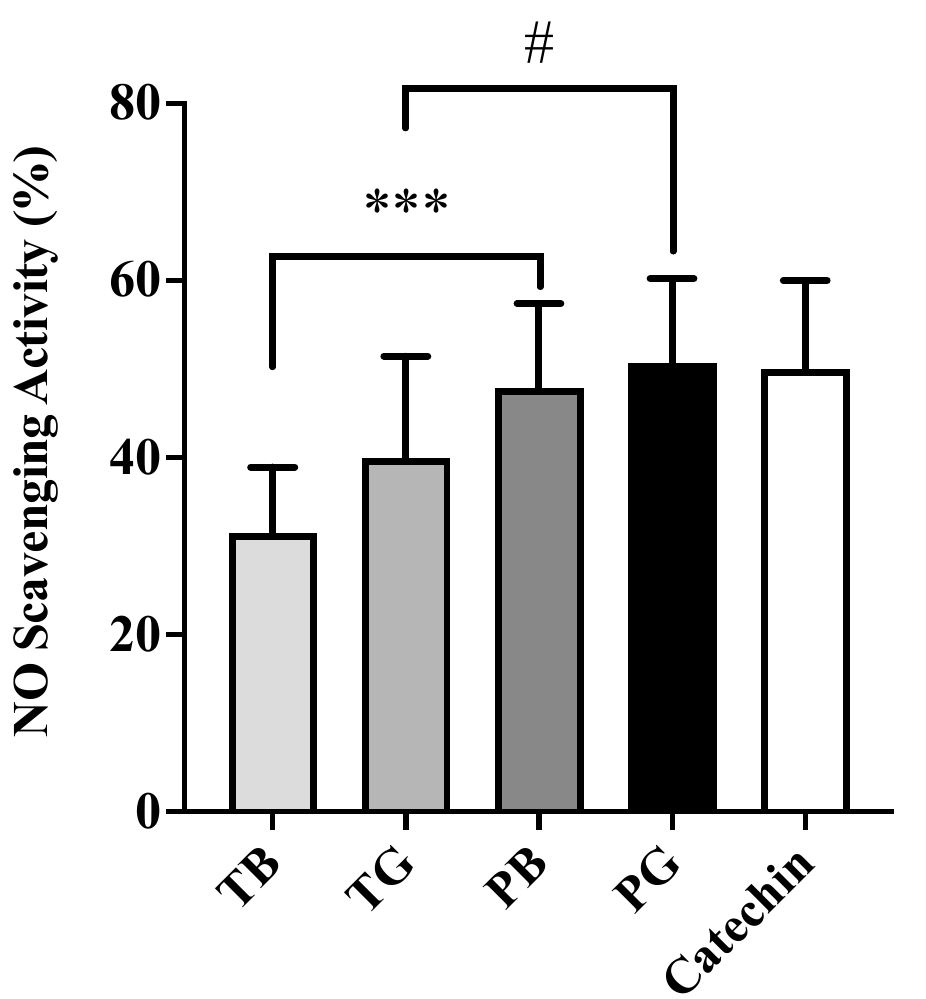
Figure 3. The scavenging ability of NO radicals of four tea extracts compared with the standard catechin as reference. The data were presented as mean ± S.E. of three independent experiments. # p < 0.05 and *** p < 0.001. Note that PG exerts the highest NO scavenging ability that was superior to catechin. NO: Nitric oxide; T: Taiwan Tea Experiment Station No. 12; P: purple shoot tea; G: green tea and B: black tea.